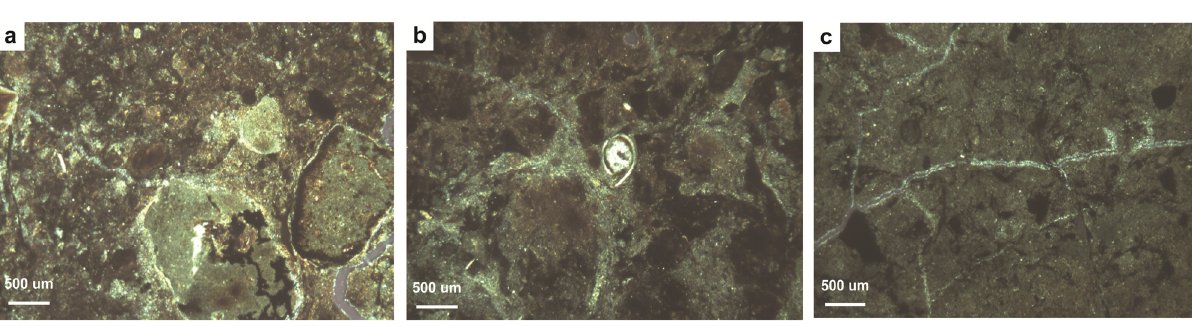
Figure 9. Microfabrics from Type D paleosol: ( a ) An agglomeroplasmic soil microfabric; ( b ) A small ostracode fossil within an insepic plasmic microfabric; ( c ) An insepic plasmic microfabric with local gleization around a